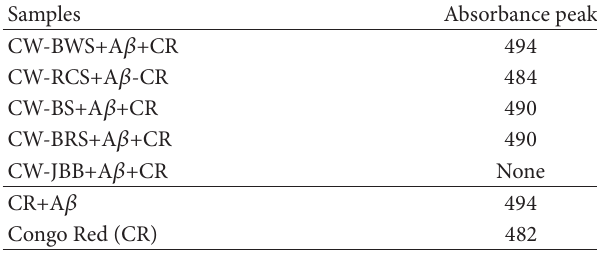
Table 3: Absorption spectrum peak determined using Congo Red (CR) assay by spectrophotometry in plant sprouts’ aqueous extracts (PSAE). We selected five plant sprouts (buckwheat sprout